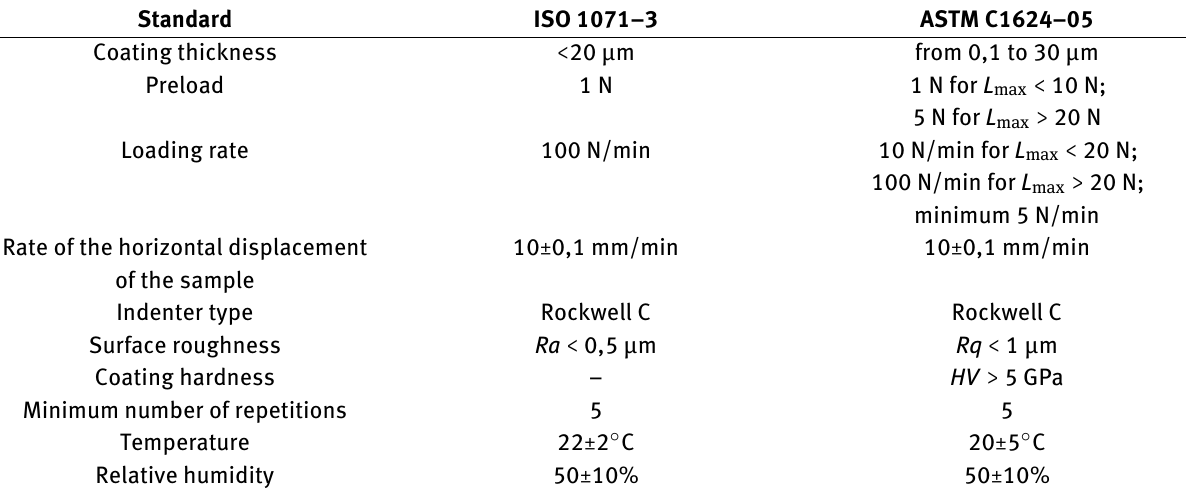
Table 2: Standard scratch adhesion test parameter values (PLST mode) (based on